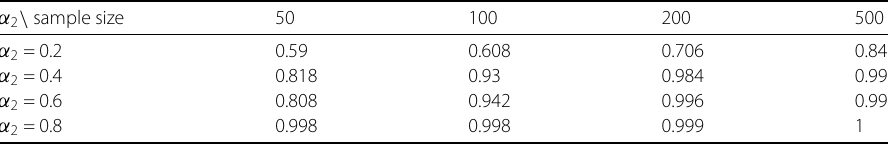
Table 6 Empirical powers for Model III with λ = 1 α 2 \ sample size 50 100 200 500 α 2 =